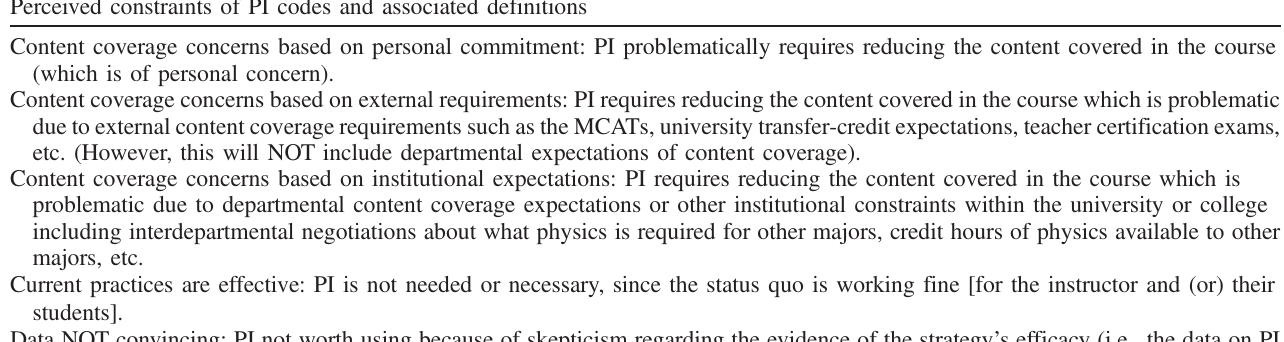
TABLE VII. Definitions of perceived constraints of PI use codes (alphabetically). Perceived constraints of PI codes and associated